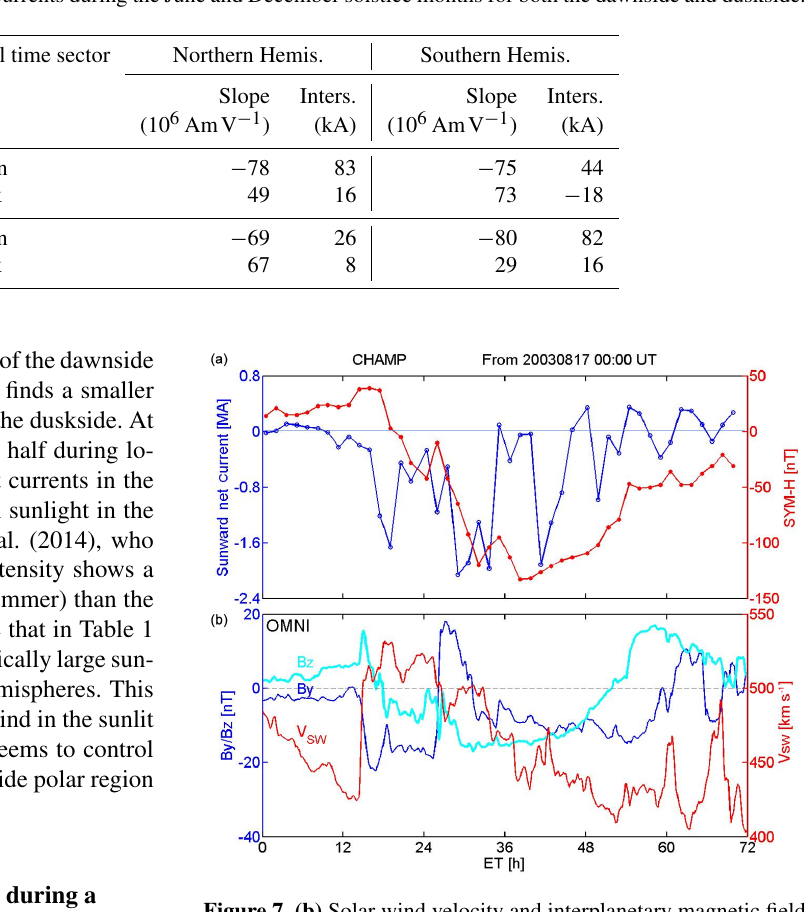
Figure 7. (b) Solar wind velocity and interplanetary magnetic field components (GSM) variations for the storm starting on 17 Au- gust 2003. (a) The SYM-H index evolution during the storm and the total anti-sunward net current are shown for